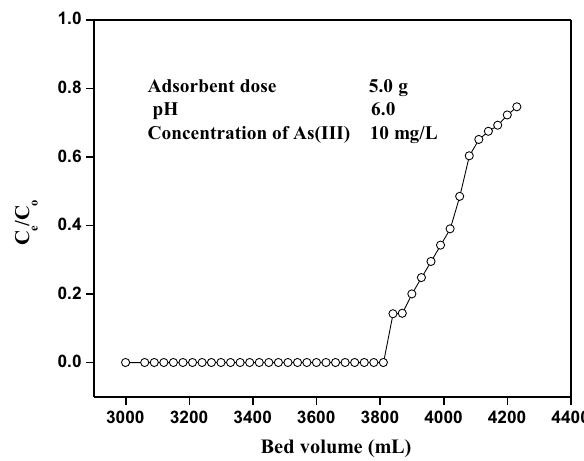
Fig. 9 Breakthrough curve of column study of arsenic